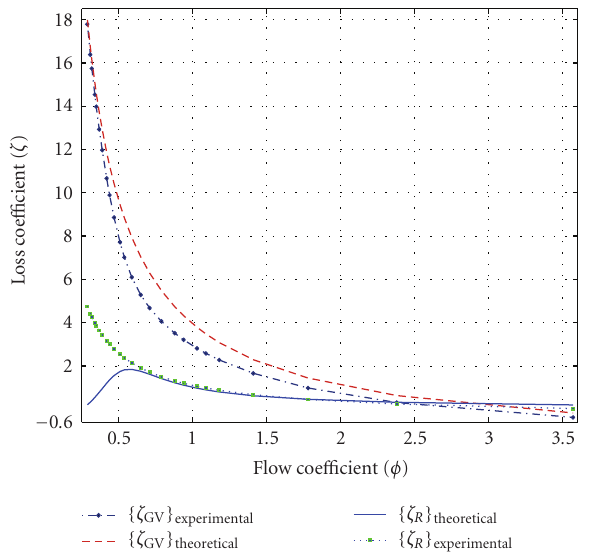
angle getting closer to the optimum and the boundary layer approaching the turbulent state. Furthermore, this